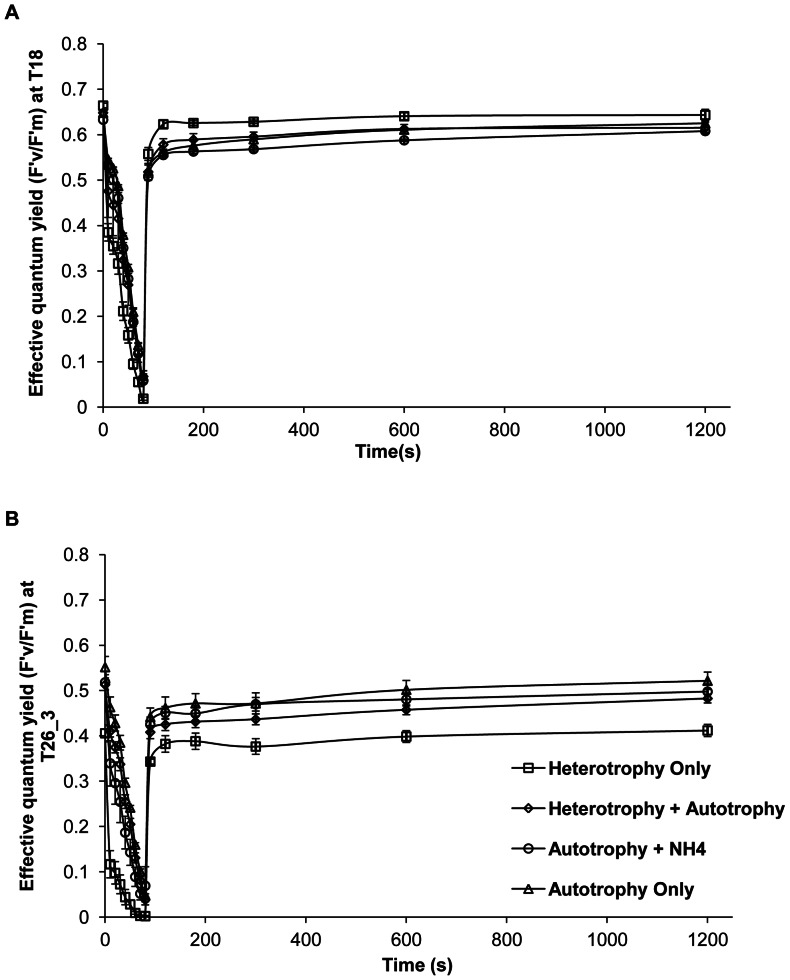
Effect of nutritional diets and thermal stress on effective quantum yield and recovery during the RLC (rapid light curve).Effective quantum yield (F'v/F'm) and recovery versus Time(s) at T18 (A) and T26_3 (B).